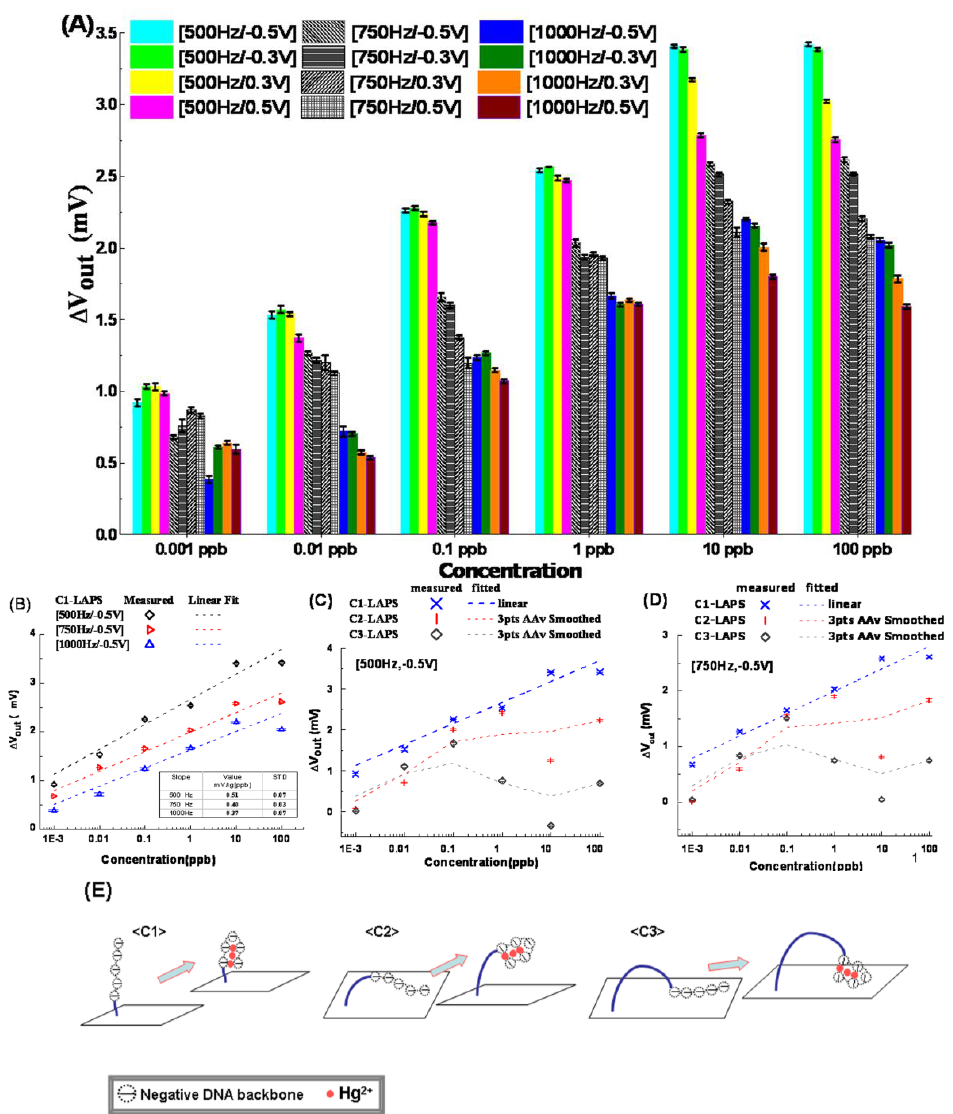
Figure 4. Results and explanations for anti-Hg 2+ modified LAPS response to Hg 2+ . ( A ) Histogram of C1 modified LAPS (C1-LAPS) response to different concentration of Hg 2+ solutions at twelve working conditions; ( B ) linear fitted curves of C1-LAPS for sensitivity analyzing; ( C , D ) at optimal